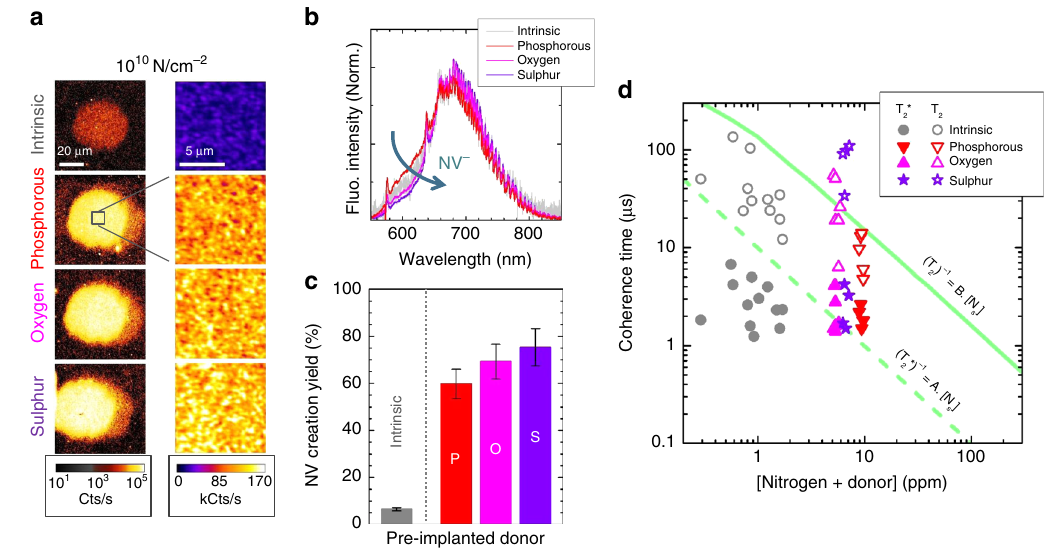
Fig. 6 NV centres with different donors. a Confocal fl uorescence scans of the NV centres created in the intrinsic and donor-doped areas (nitrogen fl uence of 1 × 10 10 cm − 2 , energy of 40 keV, annealing at 800 °C for 4 h). The different donors (phosphorous, oxygen, and sulphur) were pre-implanted and annealed at 1200 °C. The laser excitation wavelength is 532 nm and the detection window 600 – 700 nm. The fl uorescence intensity is plotted in logarithmic scale. The insets are 10 × 10 µ m² scans taken at the centre of each implanted spot, plotted in linear scale. b Fluorescence spectra (normalised) from the NV centres in the different areas. The NV − charge state stabilisation increases from P to O and S. c NV creation yield vs pre-implanted donor species, together with intrinsic diamond. Donor pre-implantation leads to one order of magnitude increase of NV density and is highest for sulphur. The error bars represent the measurement uncertainties derived from the yield formula given in supplementary Equation 3. d Coherence times T 2 and T 2 * of several single NV centres as a function of the sum of implanted nitrogen and donor concentration. The T 2 * and T 2 times are obtained, respectively, from the decay of Ramsey (free induction decay) and Hahn echo sequences applied to the single NV centres (with same fi t function used as in 39 ). The lines account for the usually observed inverse proportionality between T 2 , T 2 * and the nitrogen concentration, with A = 101 ms − 1 /ppm and B = 6.5 ms − 1 /ppm